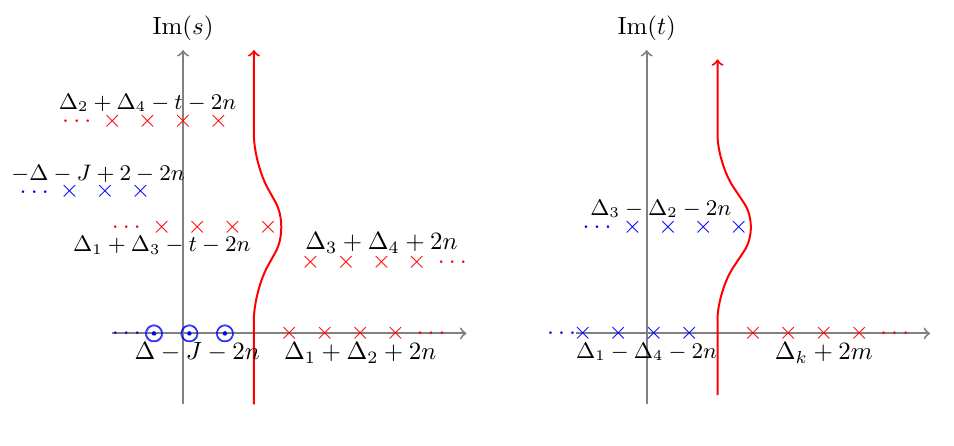
Figure 5 . Complex s and t